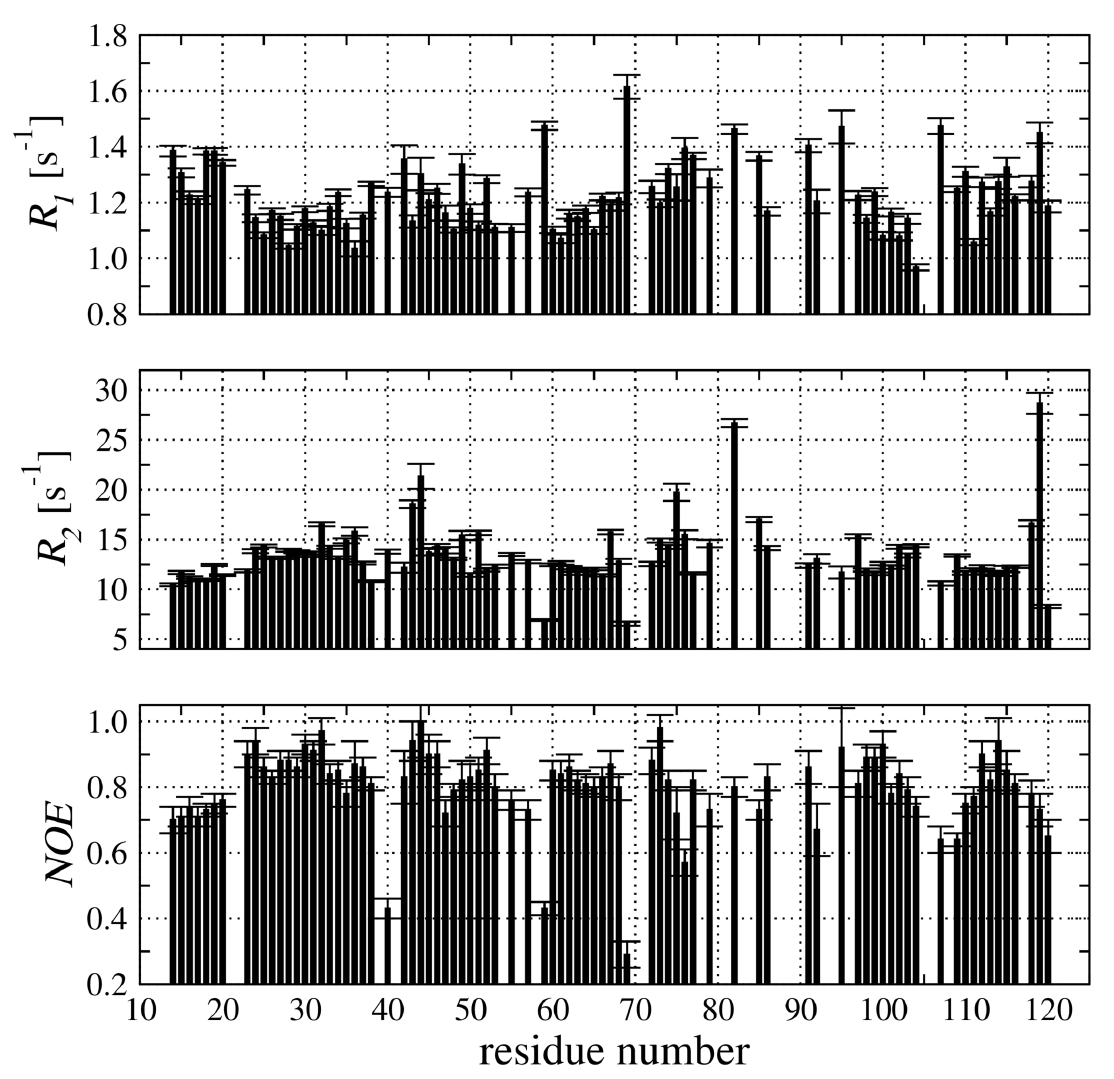
Figure 4. The R 1 , and R 2 relaxation rates together with 1 H- 15 N NOE experimental data acquired at 18.8 T and 298 K, utilizing an Agilent DDR2 NMR